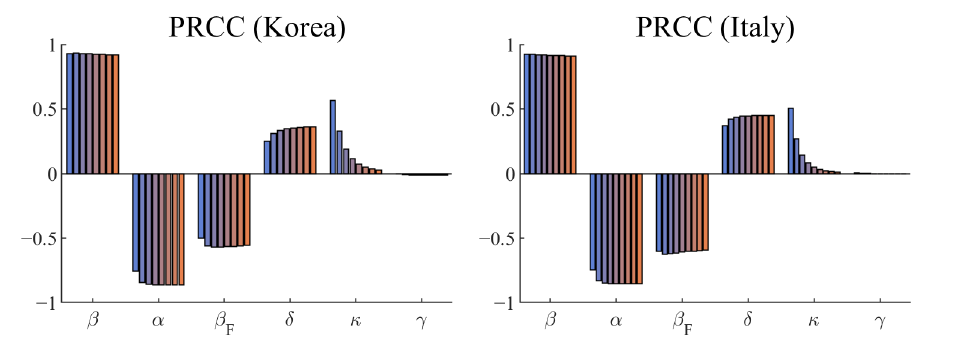
Figure 5. PRCC values depicting the sensitivities of the confirmed cumulative cases, with respect to the model parameters β , α , β F , δ , κ , and γ .